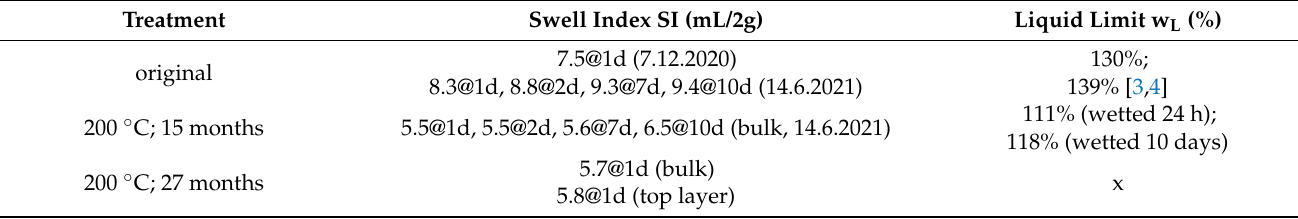
Table 4. Swell index and liquid limit of the BCV 2017.